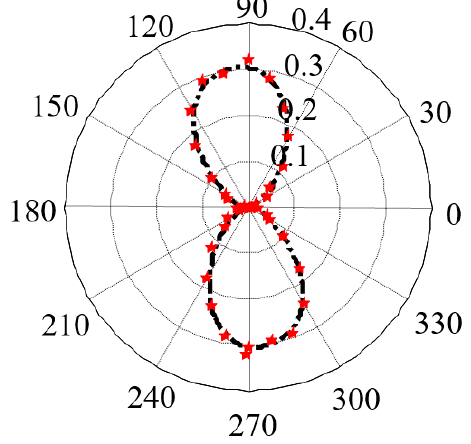
Figure 10. Magnetic anisotropy measured in X60 pipeline steel.